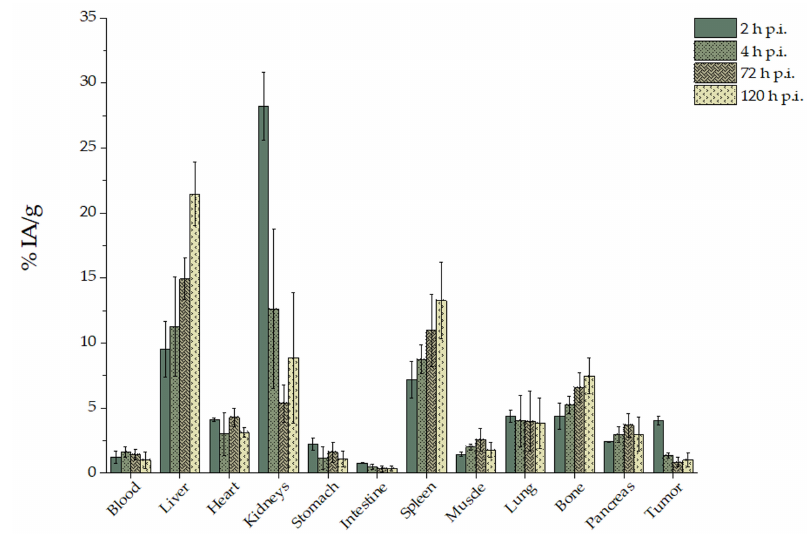
Figure 3. Ex vivo biodistribution of [ 225 Ac] 225 Ac-Au@TADOTAGA after intravenous injection. Values represent the mean ± SD ( n = 5 mice per group).